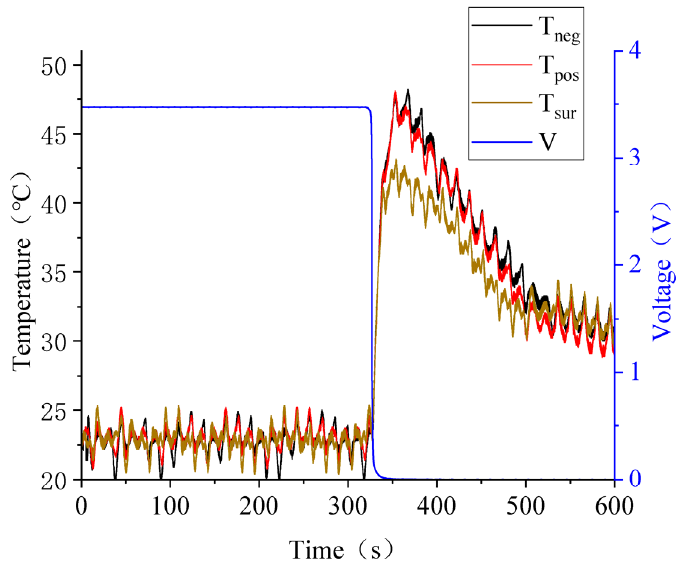
Figure 6. 0% SOC state battery curve.